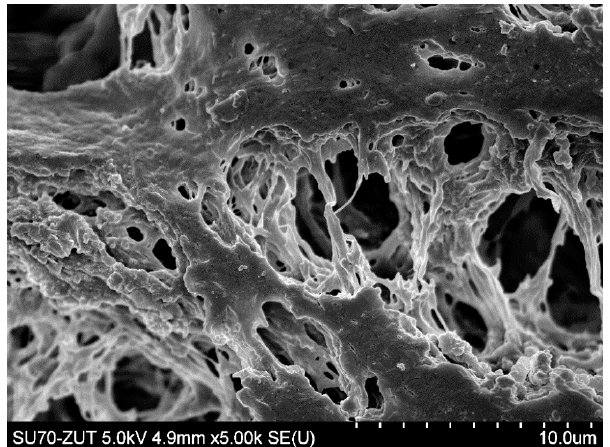
Figure 11. SEM image surface of Accurel PP S6/2 membrane. Module M1—membranes several times rinsed with 1% NaOH solution.